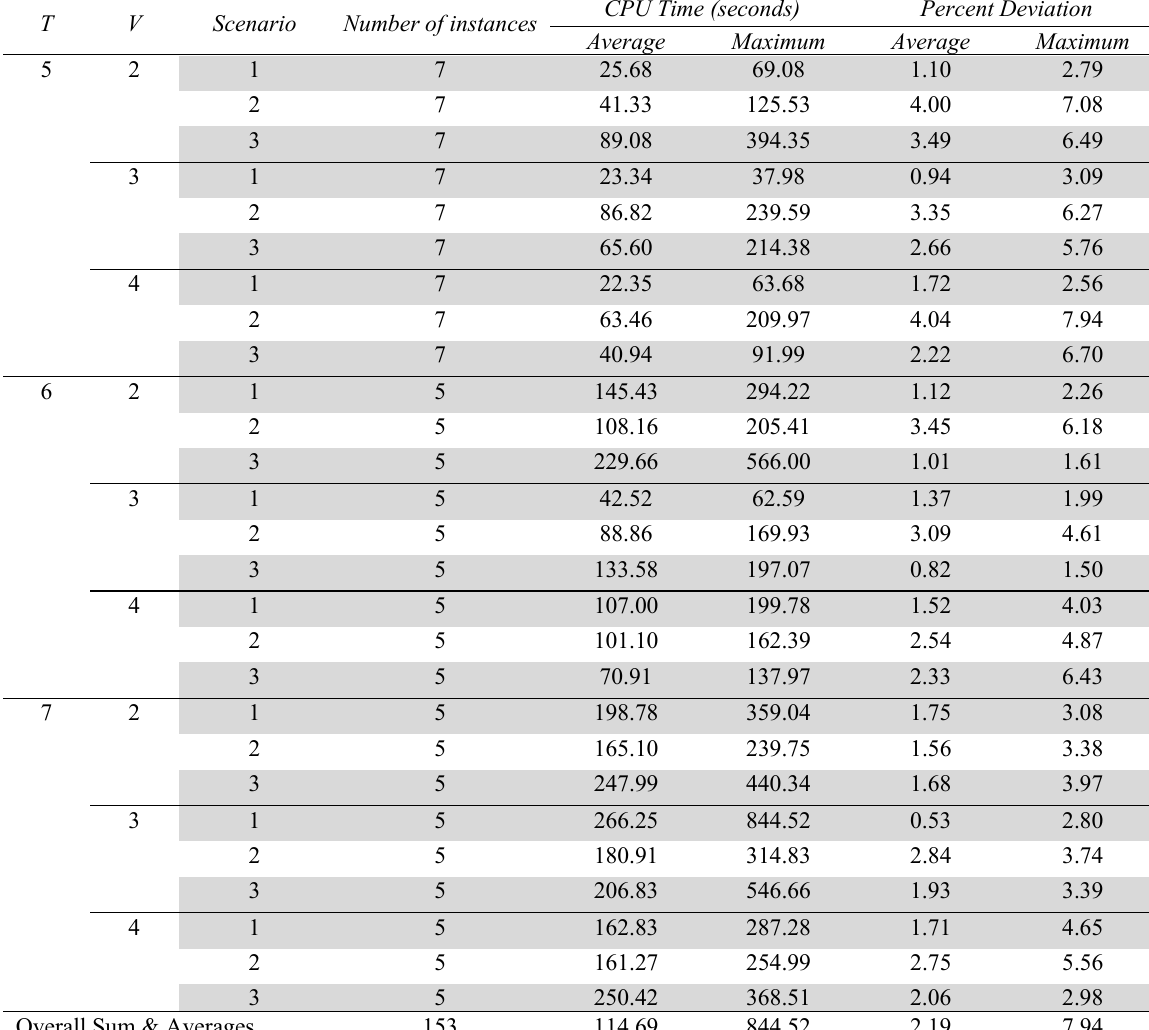
Percent deviation of the decomposition-based heuristic algorithm